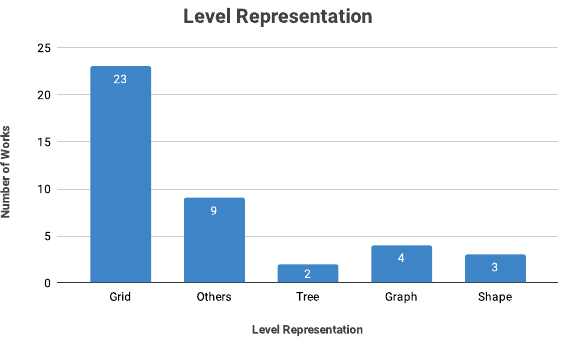
Figure 11. Number of works by level representation.